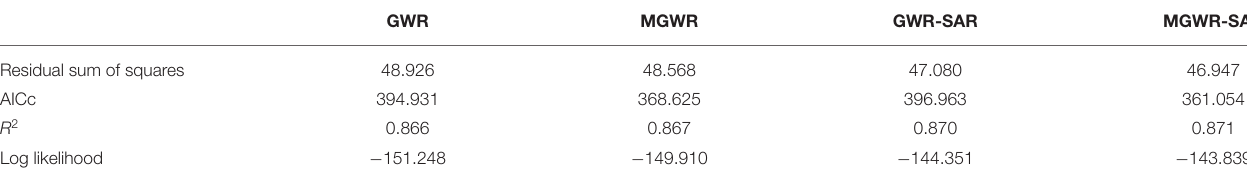
TABLE 6 | Regression results of four models.